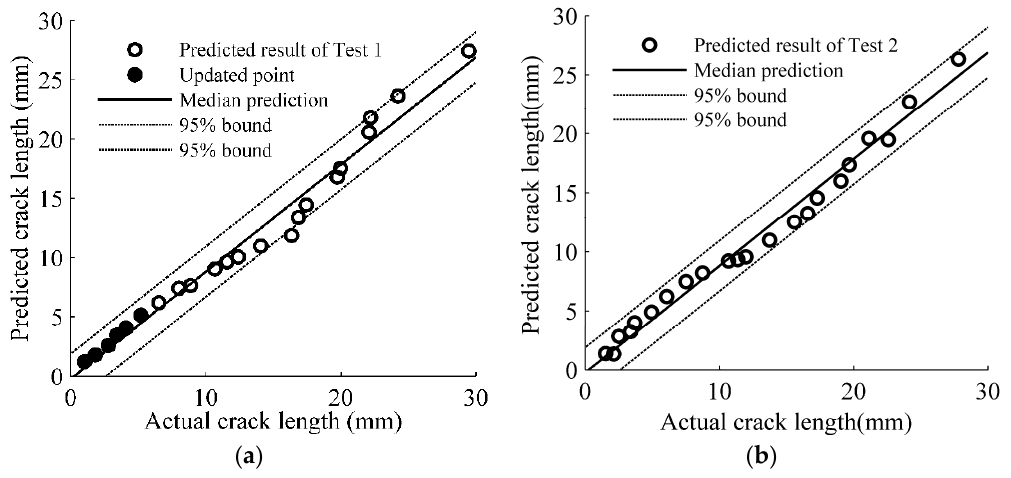
Figure 14. Comparison of updated model predictions and actual measurements: ( a ) Test 1; and ( b ) Test 2.